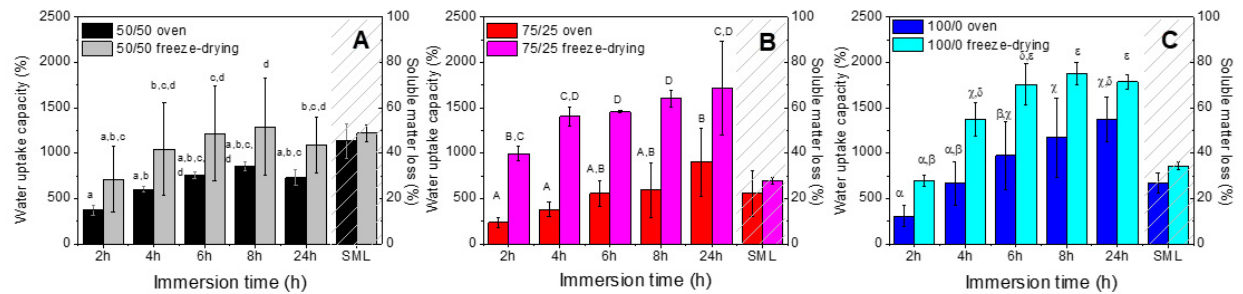
Figure 5. Water uptake kinetics for dried porcine plasma protein (PPP)-based matrices initially plasticized with glycerol (Gly) with different PPP/Gly ratios, 50/50 ( A ), 75/25 ( B ), and 100/0 ( C ), after drying either by freeze-drying or by heat-drying in a natural convection oven.